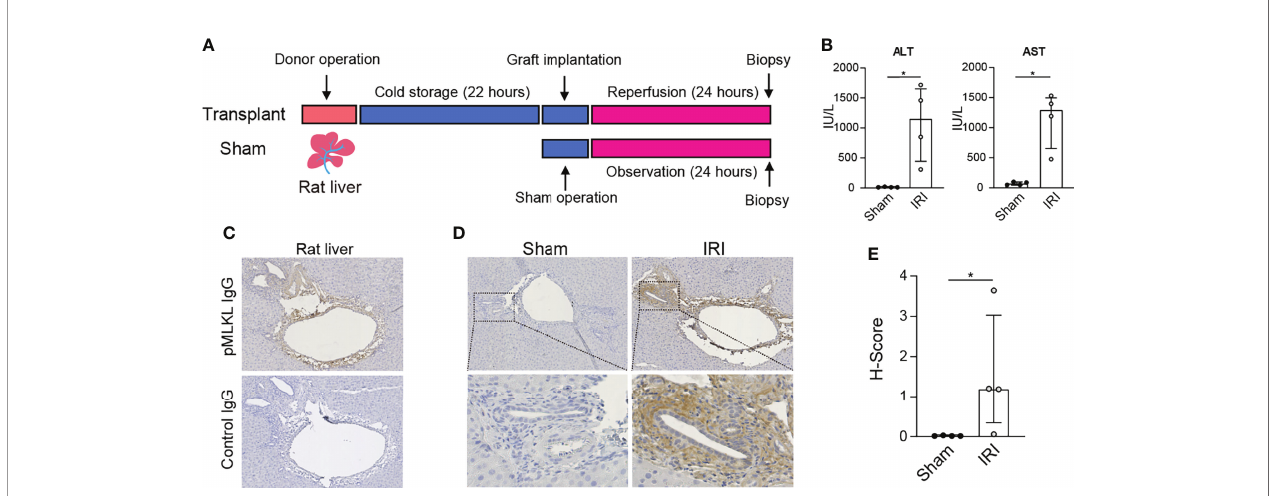
FIGURE 1 | Expression of pMLKL in graft livers from the rat LT model. (A) Schematic representation of the timeline. Rat livers were procured and stored in cold preservation solution for 22 hours and then transplanted. Liver biopsies (n=4) were taken after 24 hours of reperfusion. (B) Serum ALT and AST in recipient rats after 24 hours of reperfusion were determined. The levels of both ALT and AST increased signi fi cantly in the IRI group compared with sham-operated rats. (C) Immunohistochemistry was performed on collected rat liver after IRI. Serial sections were stained with either pMLKL or a negative isotype control antibody. Shown is a representative microscopic image (magni fi cation, 100X) con fi rming the speci fi city of the pMLKL antibody and the secondary antibody. (D) Representative microscopic images of pMLKL staining on rat livers undergoing either IRI or sham operation were shown (magni fi cation, 100X). Enlarged images from the boxed area are shown in the bottom panel (magni fi cation, 400X). Clear pMLKL was detected in the portal triads of rat liver undergoing IRI, but not in the sham-operated rats. (E) The H-Score of pMLKL staining was compared in rat donor liver undergoing hepatic IRI or sham operation (Mann-Whitney test), in which a signi fi cant increase in the IRI group was observed. *p <